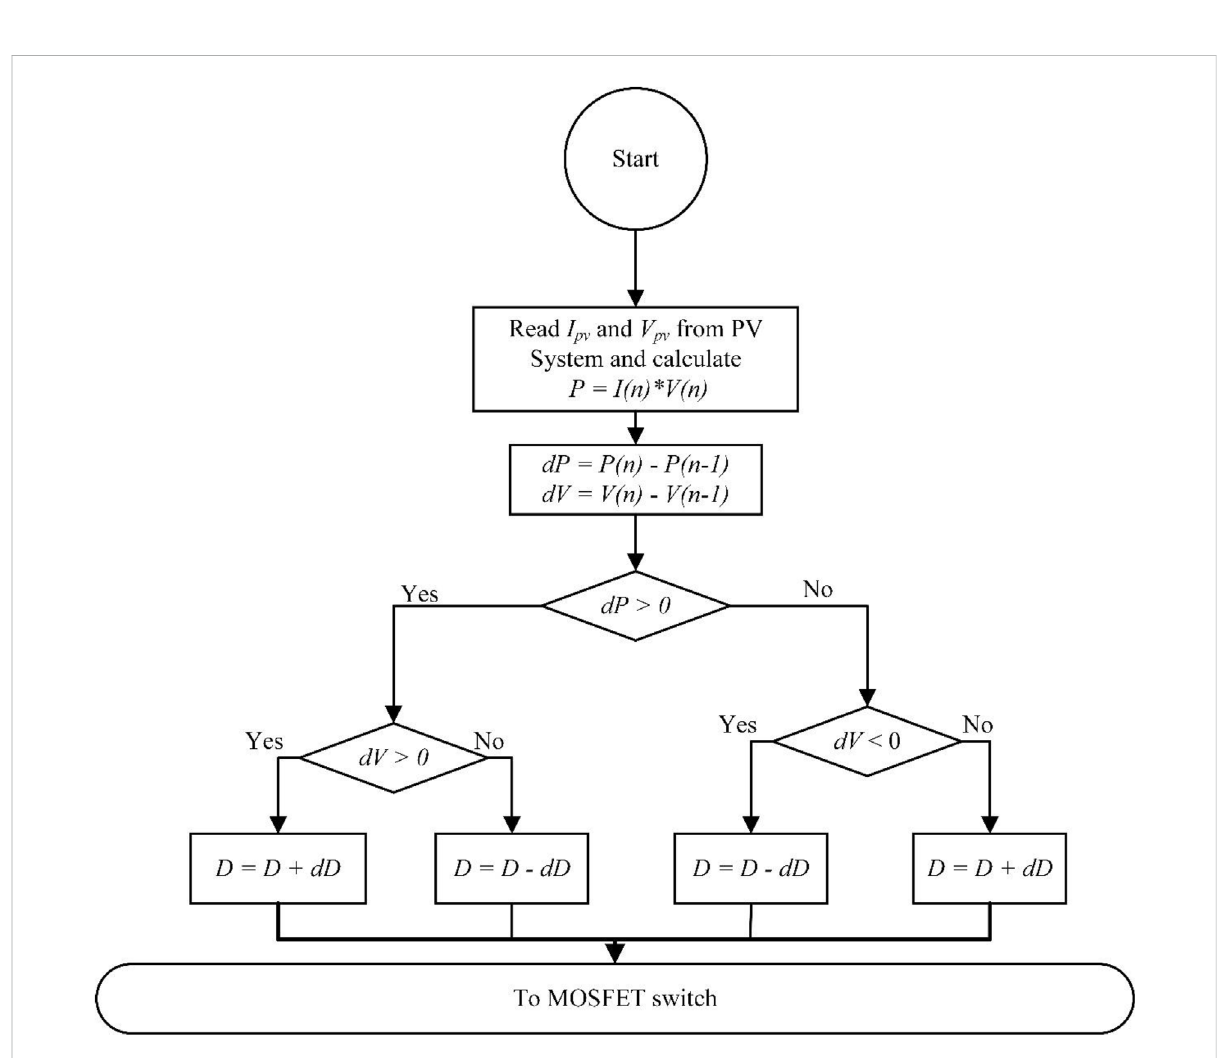
FIGURE 8 Flowchart of P&O